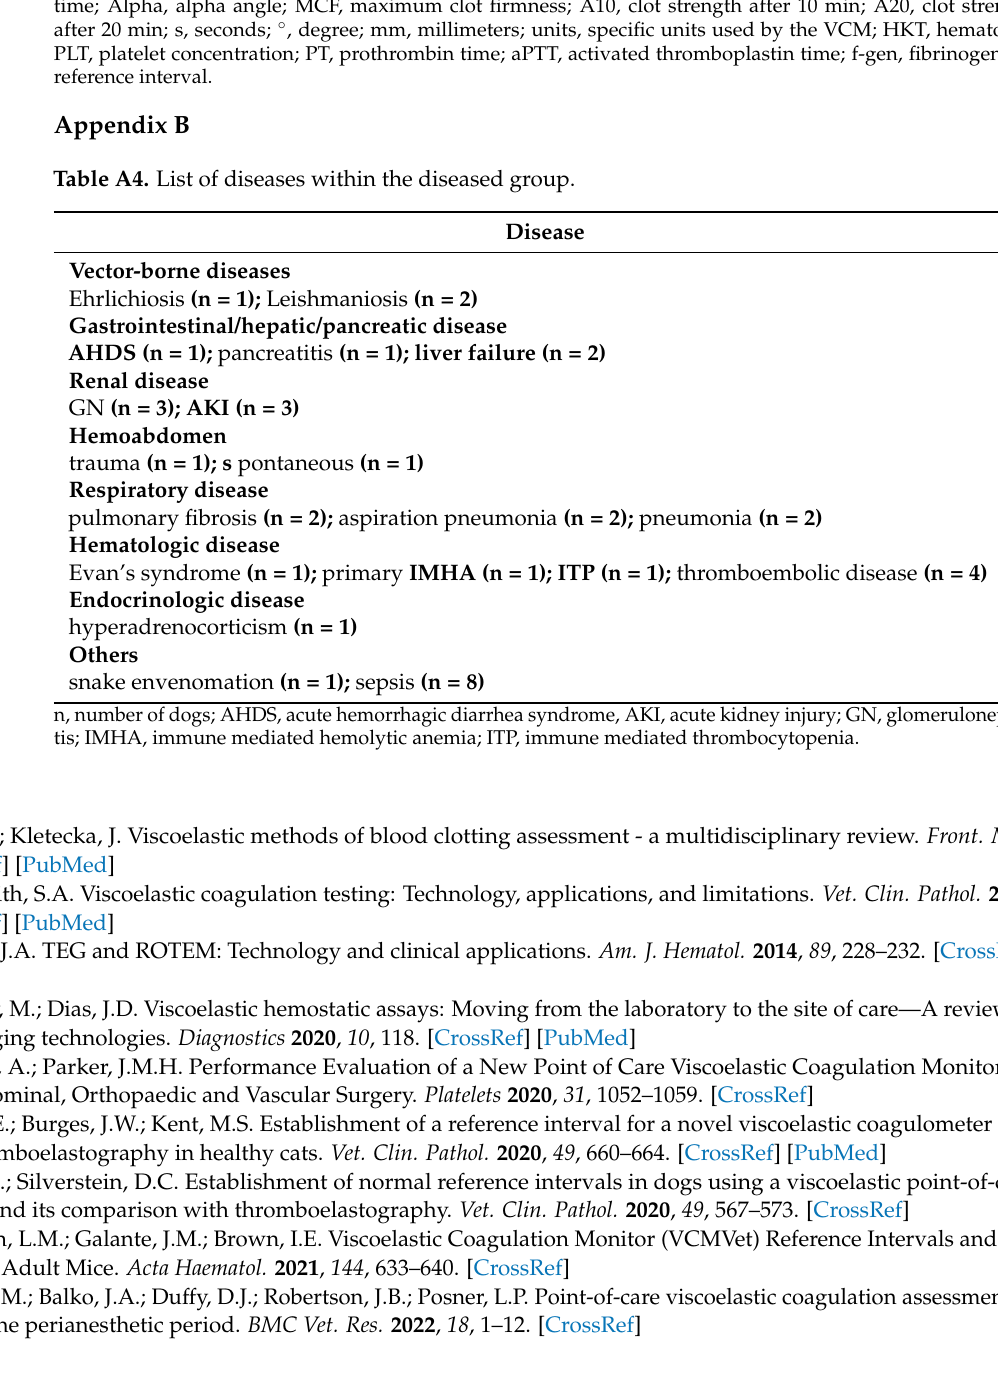
Table A4. List of diseases within the diseased group. Vector-borne